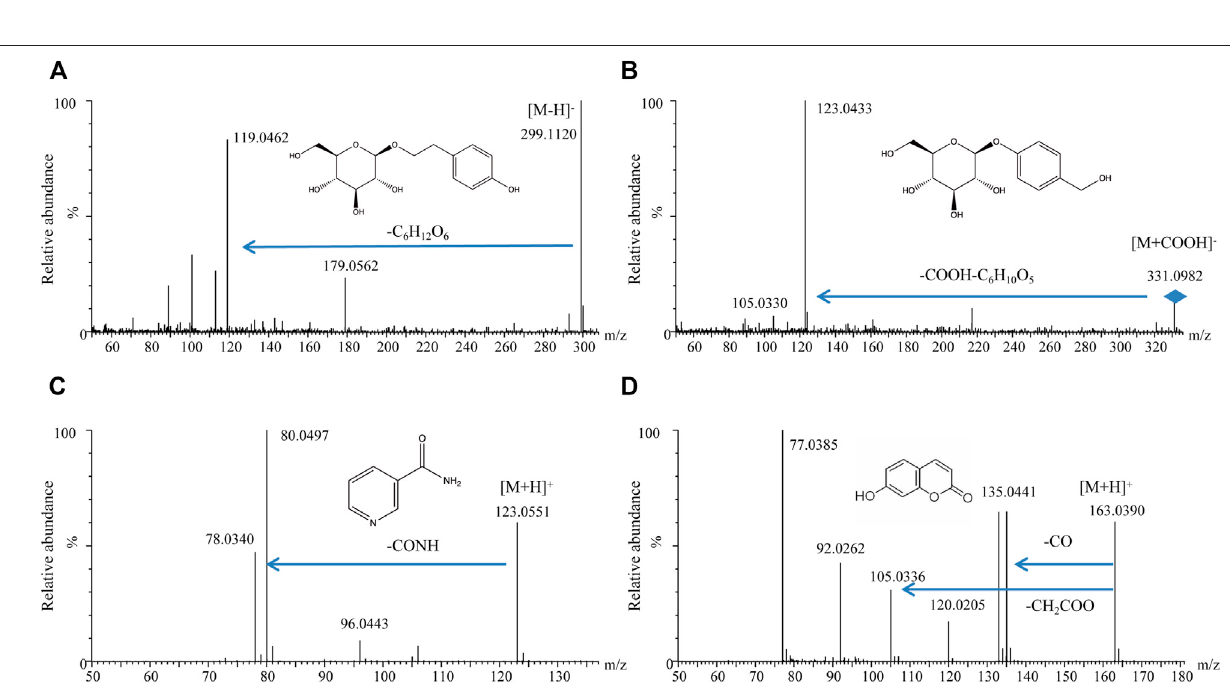
Frontiers in Pharmacology |